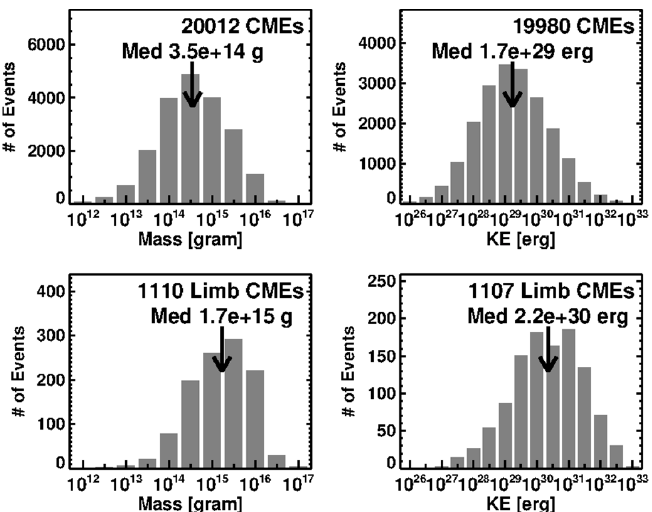
Figure 4. # means Number in Figure 4. Mass ( left column ) and kinetic energy ( right column ) of SOHO/LASCO CMEs from January 1996 to December 2020. The upper ( lower ) panels correspond to all ( limb ) CMEs.